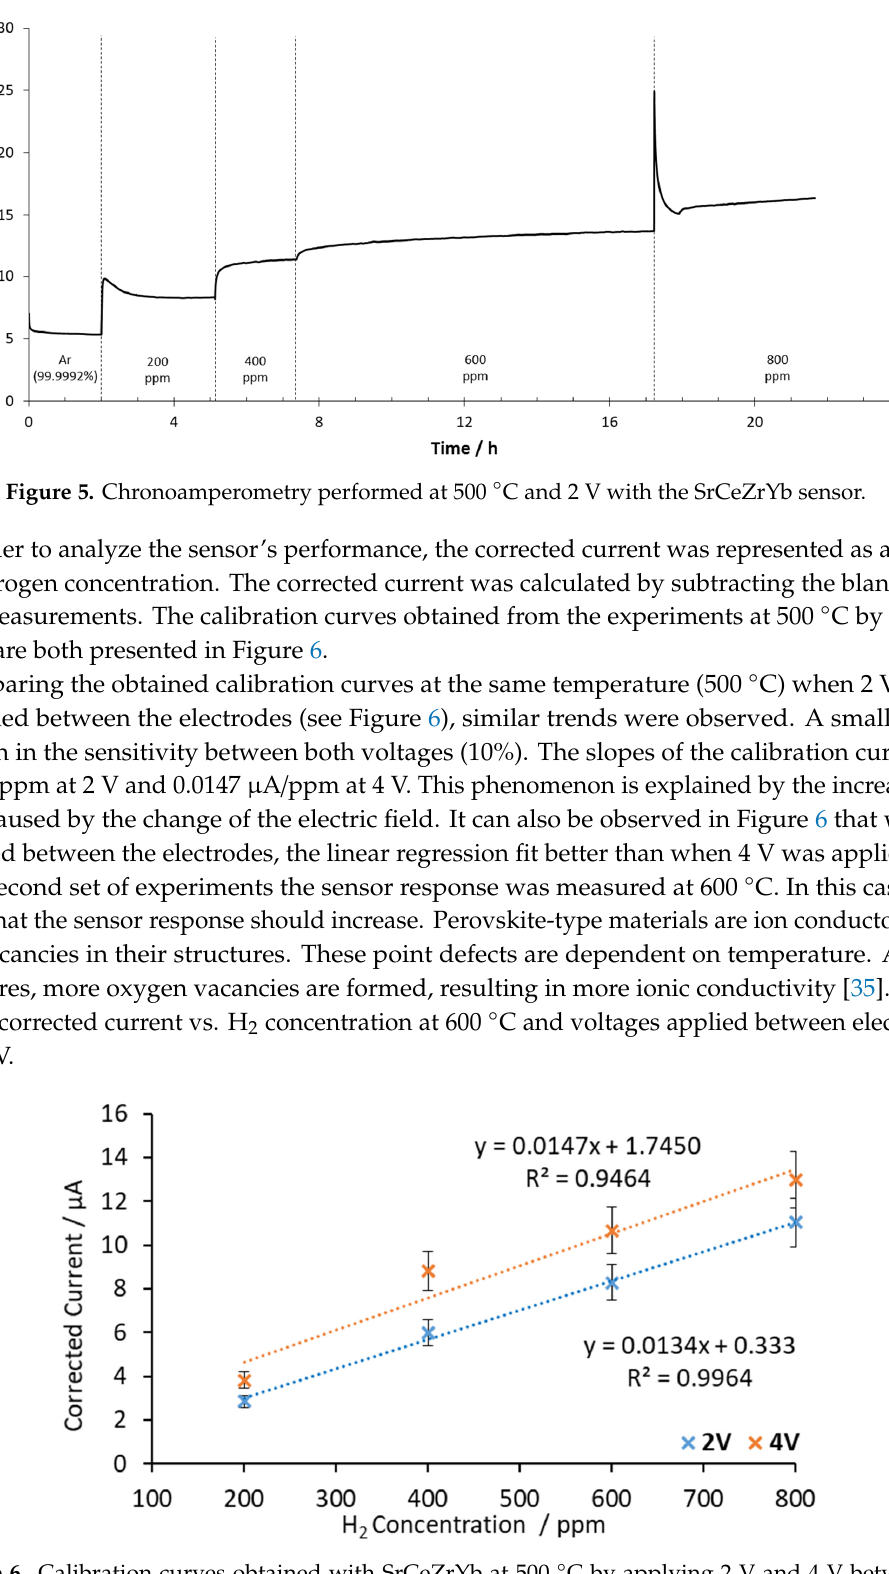
Figure 6. Calibration curves obtained with SrCeZrYb at 500 °C by applying 2 V and 4 V between the